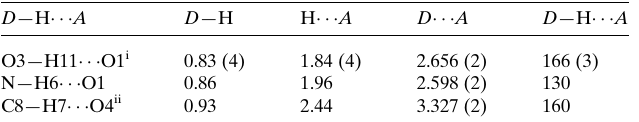
Table 5 Hydrogen-bond geometry (A˚ , (cid:3) ) for 2 .